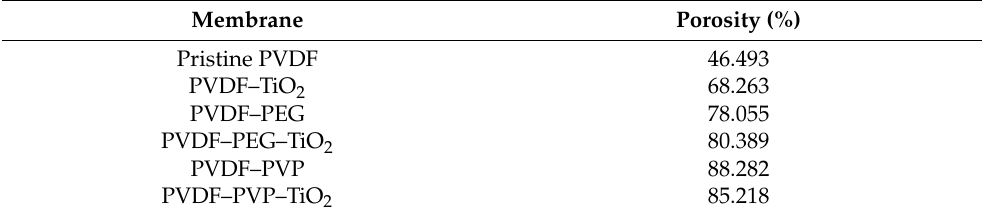
Table 3. Porosity of